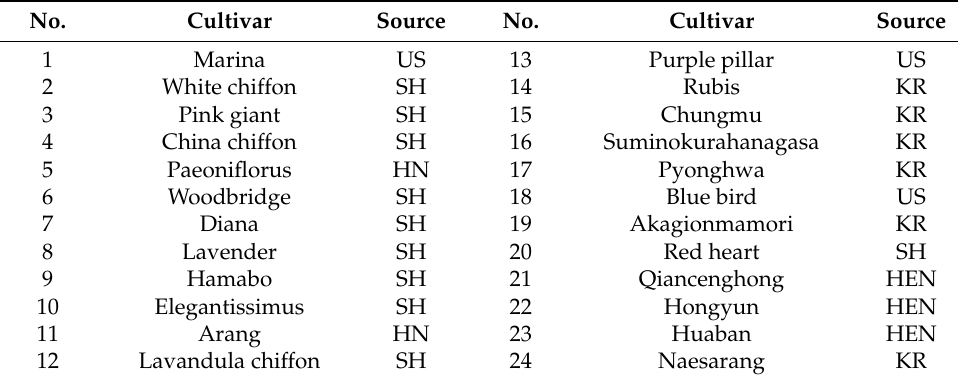
Table 1. Information about the 24 Hibiscus syriacus